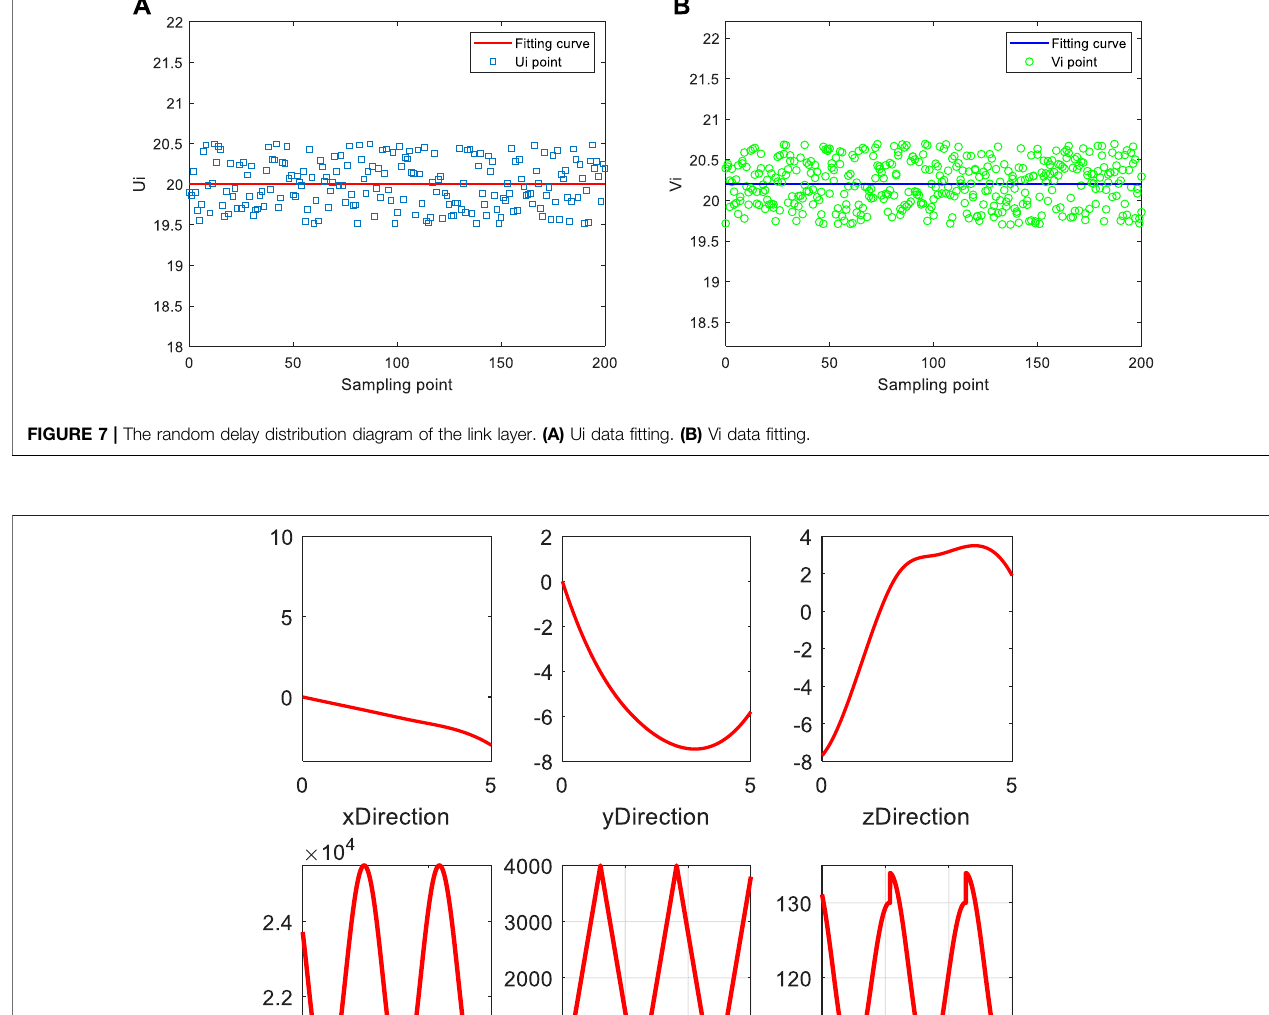
Frontiers in Bioengineering and Biotechnology |